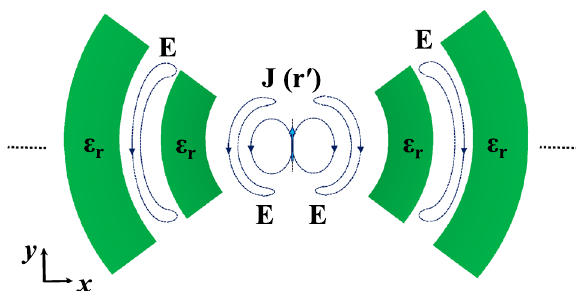
Figure 6. Electric current source in between dielectric slabs, semi-ring shape.